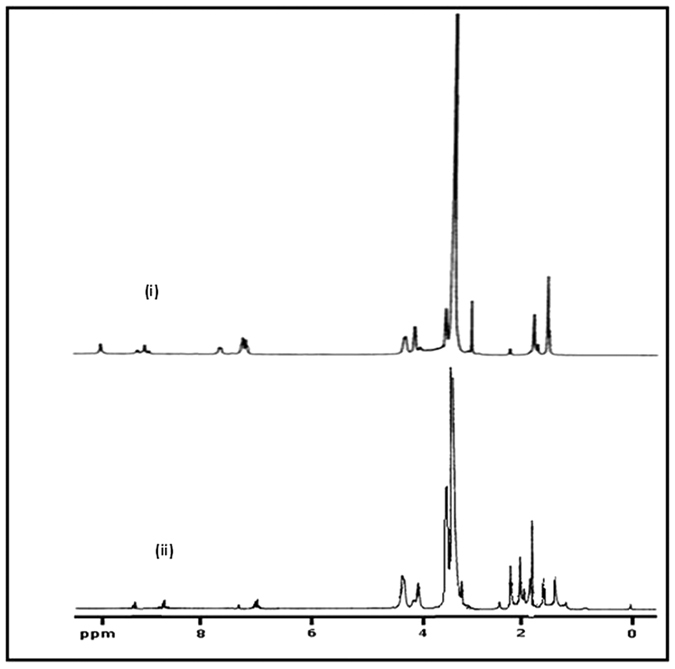
1H NMR of (i) Br-PEOPU-Br and (ii) PDMAEMA-PU- PDMAEMA.